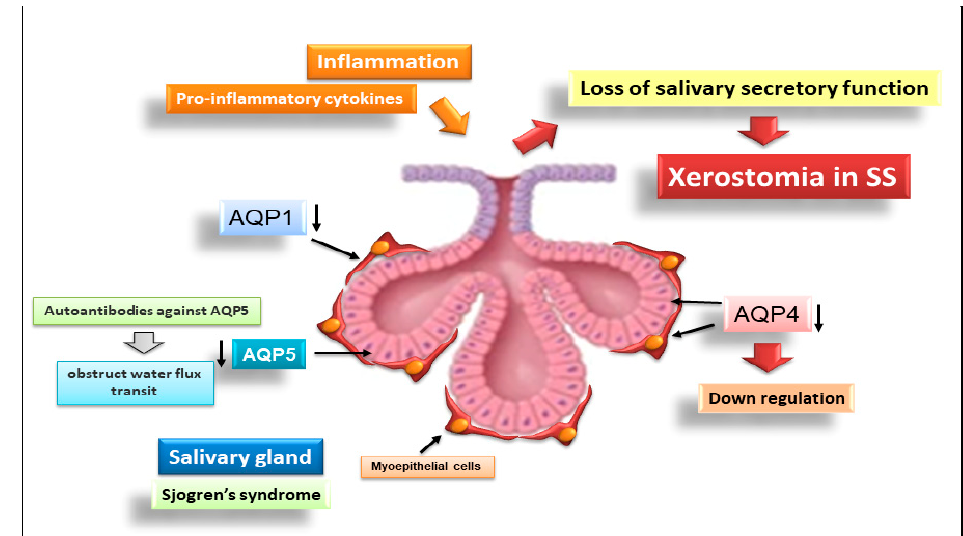
Figure 4. Advances in AQP research in SS (aquaporin,